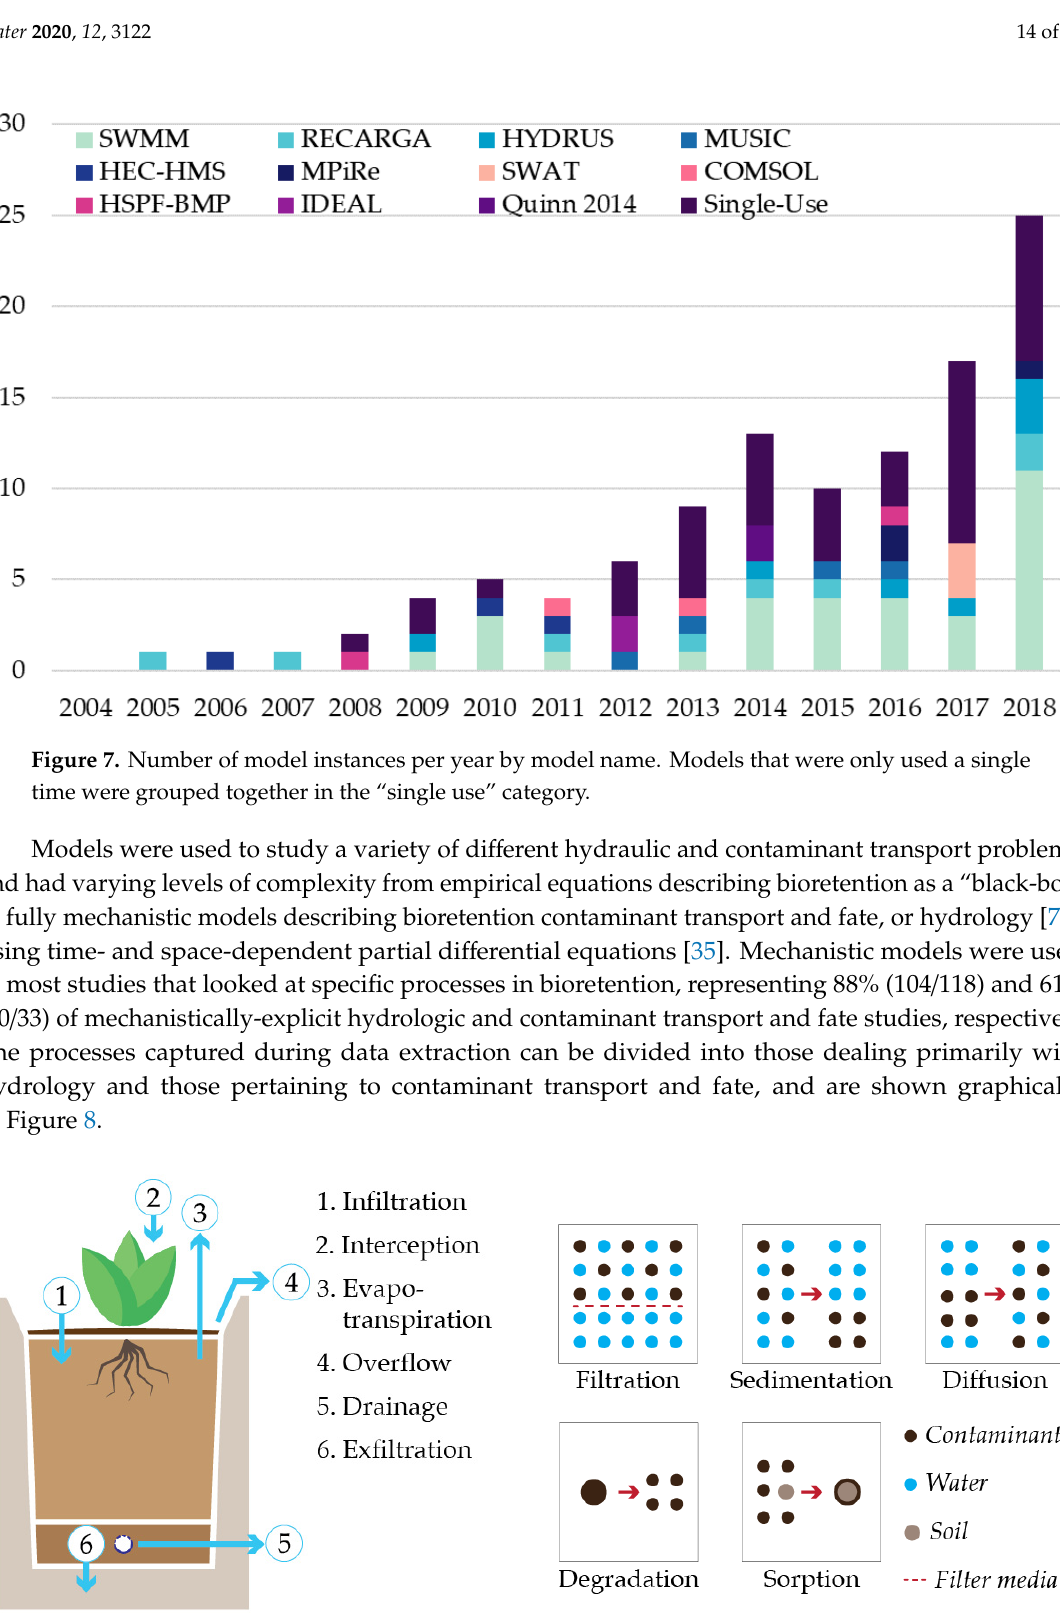
Figure 8. Processes shown in Bioretention Models for Hydrology and Contaminant Transport Models.